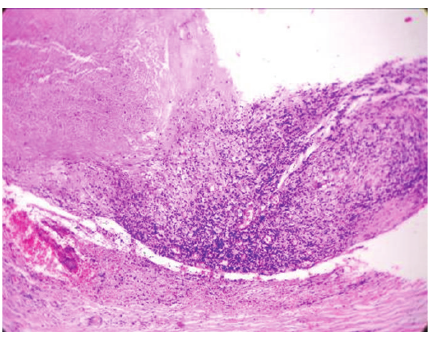
Figure 8: (Case 2): ulnar nerve biopsy showing caseating epithe- lioid granuloma (H&E ×